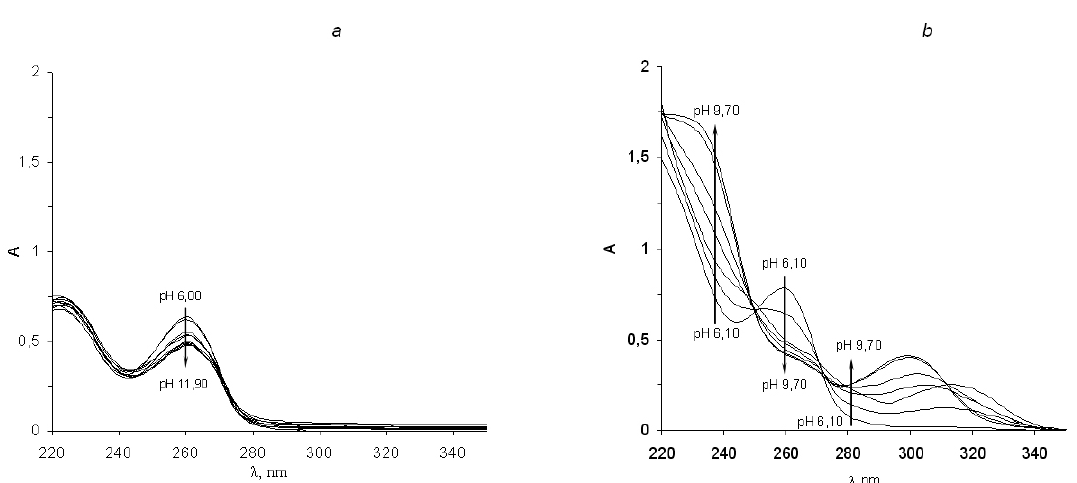
I at different pH in water (a) and in the presence of 0.5 mM H 3